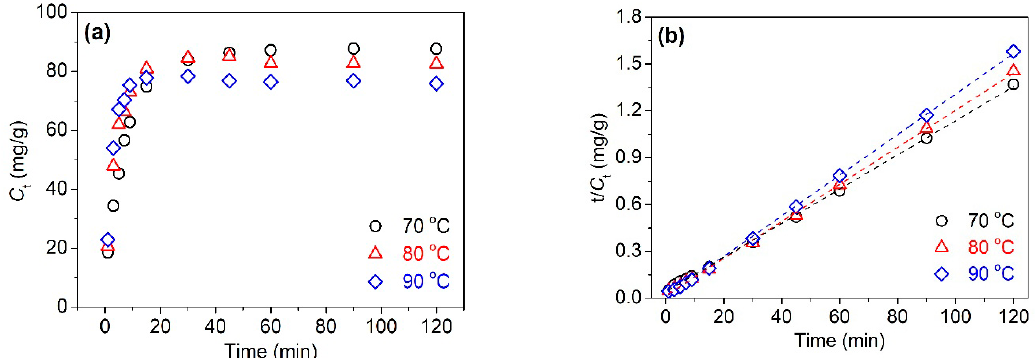
Figure 3. Adsorption rates of tannic acid ( a ) for silk and it plots as per the pseudo-second-order equation ( b ) at three temperatures.